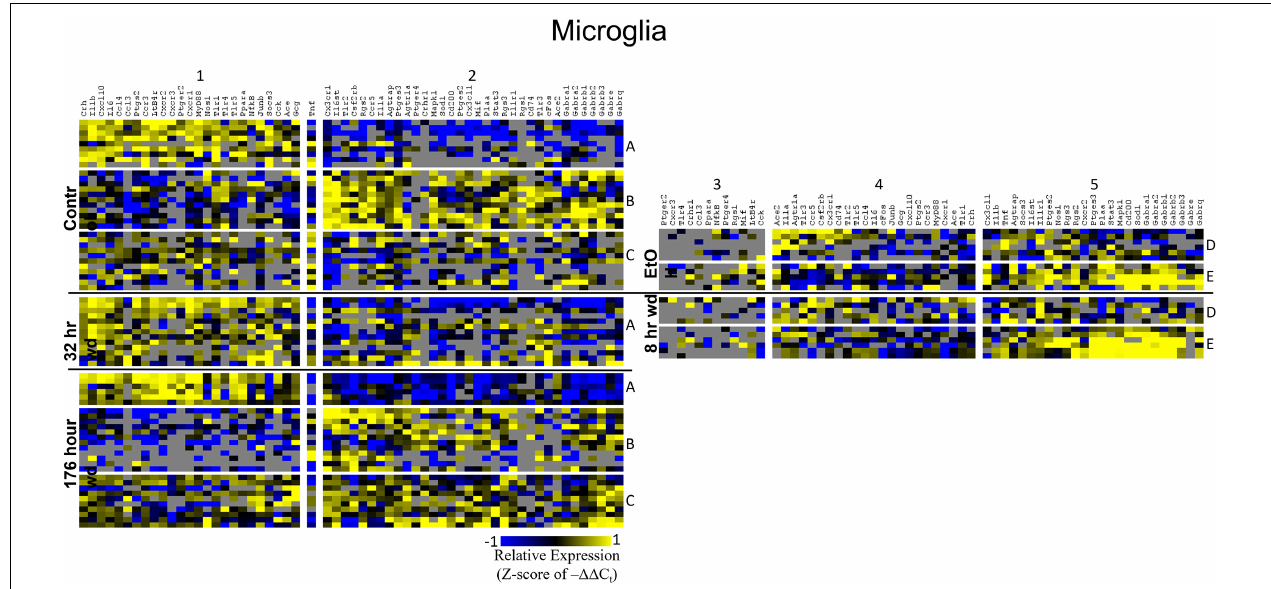
FIGURE 5 | Heat Map of Microglia. Heat map displays microglia cellular subphenotypes through alcohol withdrawal time series. Rows represent 10-cell pooled samples with cellular subphenotype clusters labeled with uppercase letters. Columns represent the z-score of – (cid:49)(cid:49) C t gene expression values on a –1 to 1 color scale for that gene in that sample. Gene clusters are labeled by